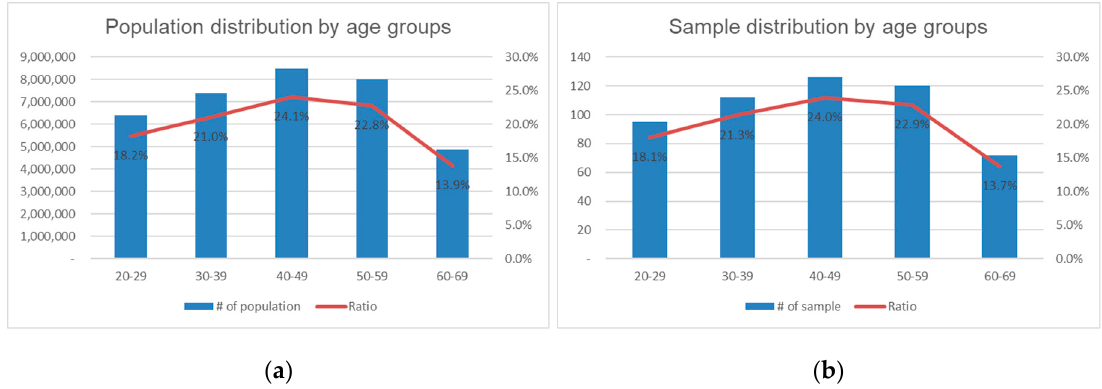
Figure A2. Comparison between research population and survey sample by age composition; ( a ) Population distribution; ( b ) Sample distribution; Source: Statistic Korea [49].